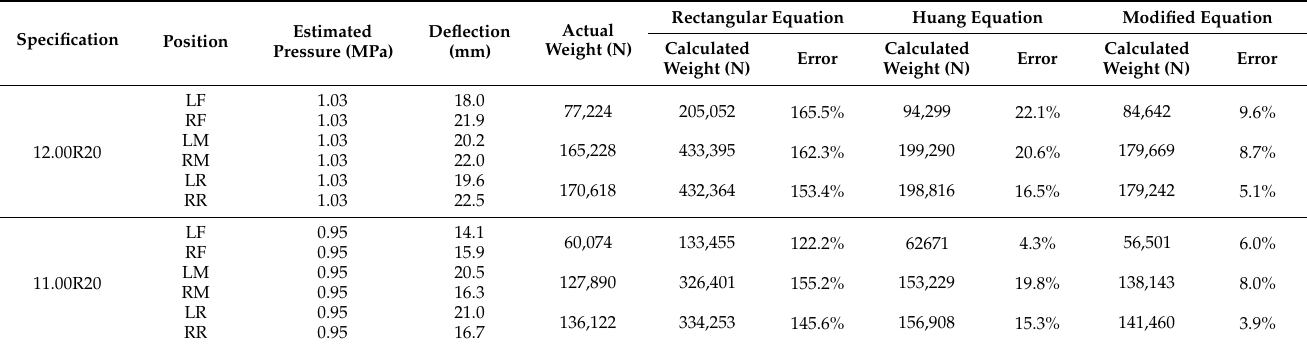
Table 7. Axle weight identification results for trucks.